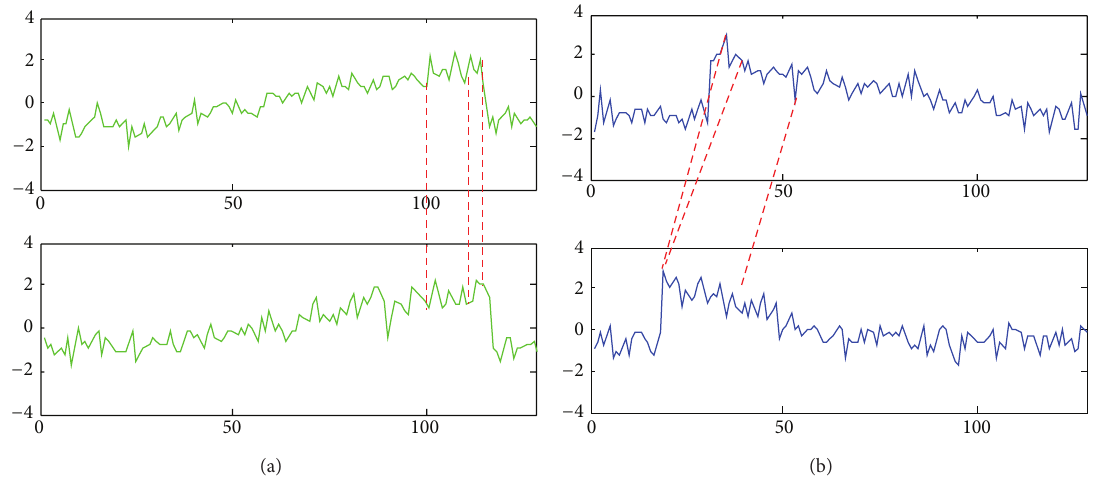
Figure 1: Similarity in shape (b) and similarity in time (a) between two time series